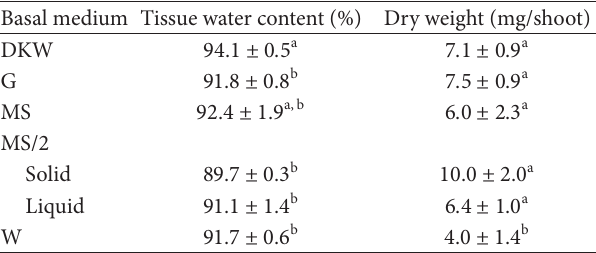
Table 2: Effect of basal media formulations on tissue water content (TWC) and biomass accumulation in shoots of C. heterophyllus after 4 weeks of culture in liquid